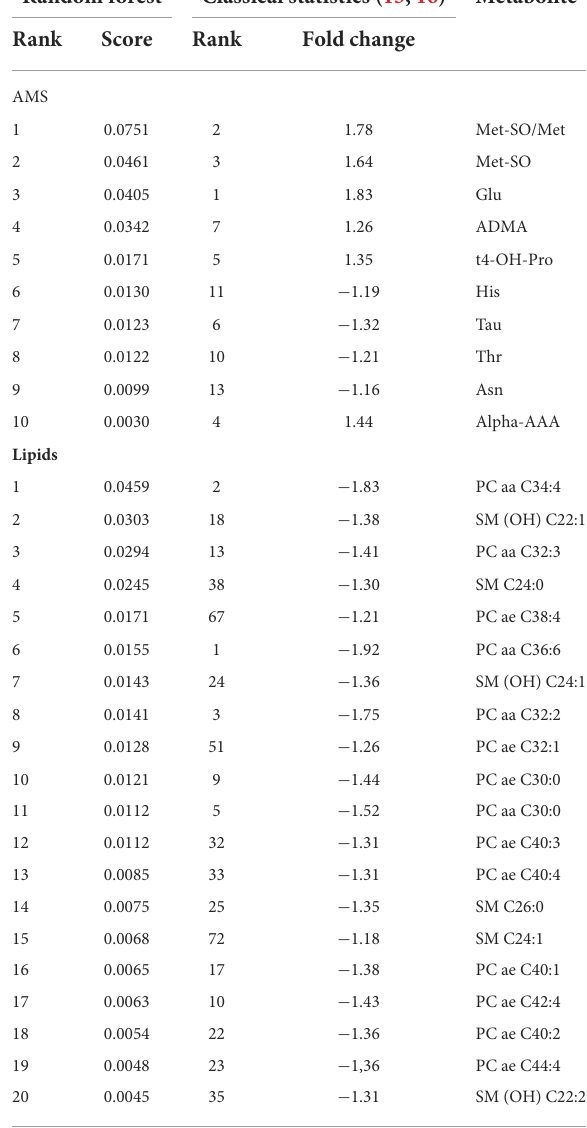
TABLE 1 Random forest